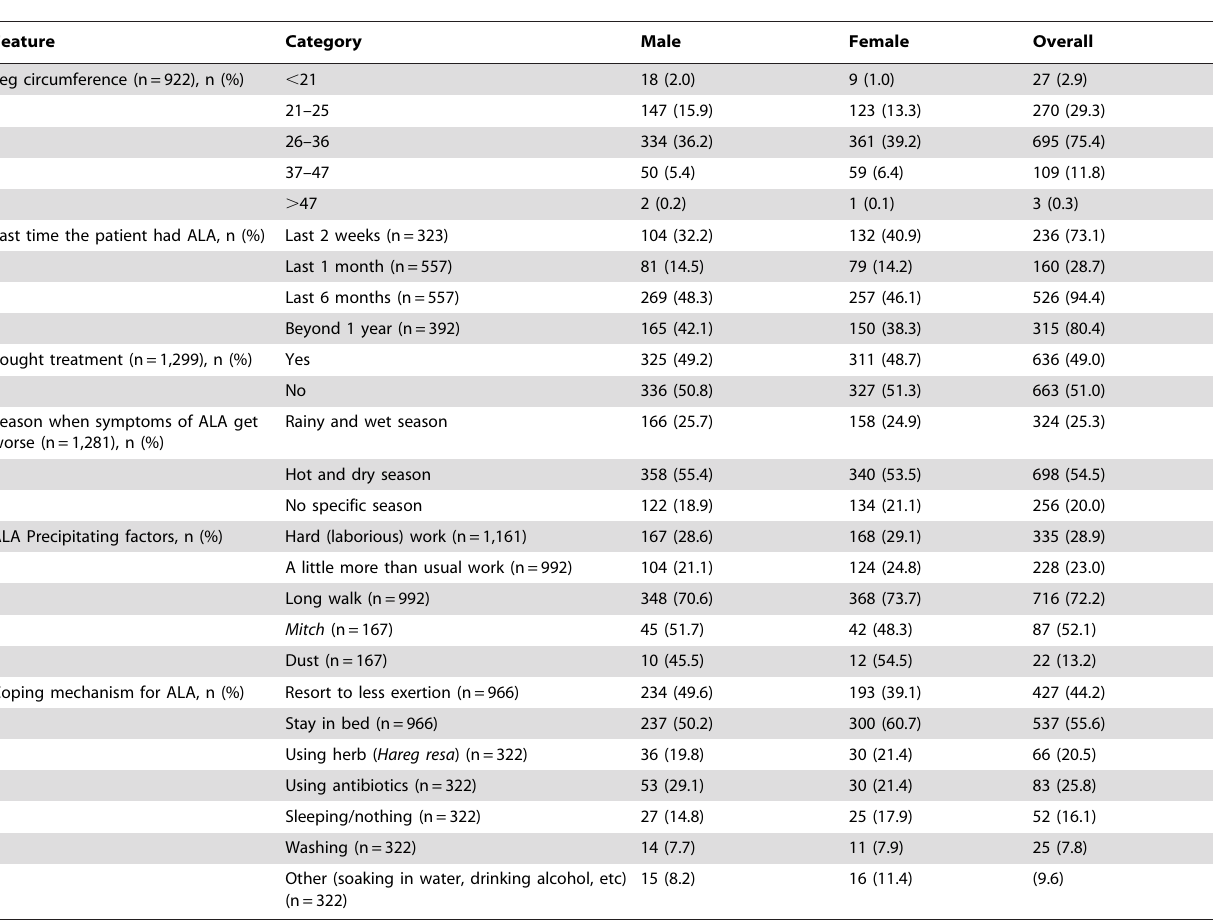
Table 4. Features of acute lymphadenitis (ALA) in podoconiosis patients.